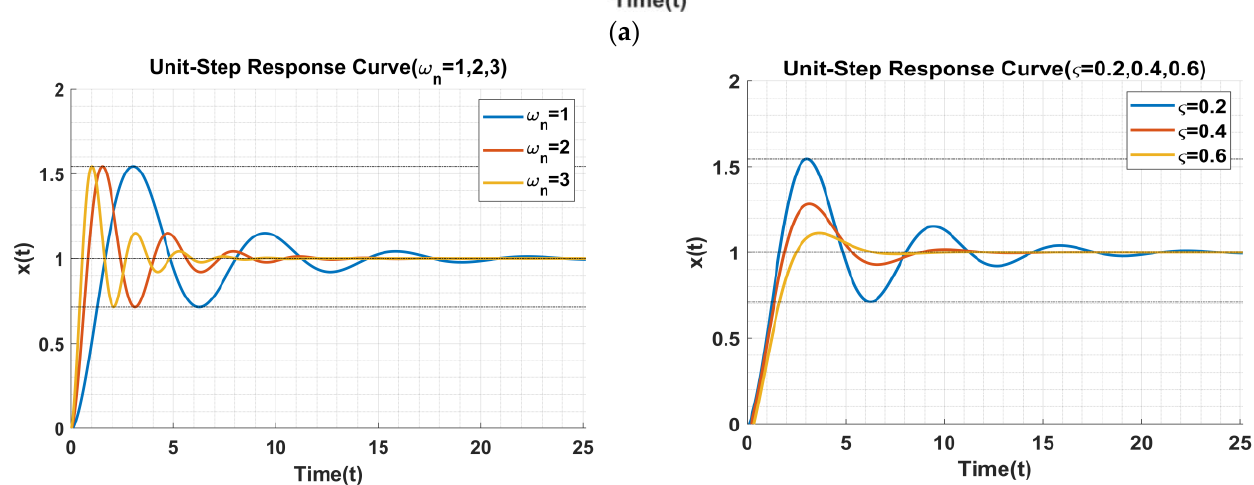
Table 1. Dynamic index of second-order, underdamped system.